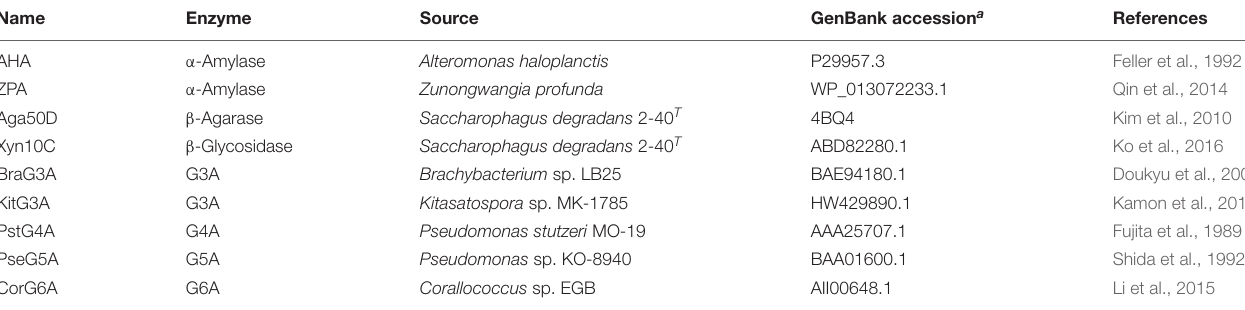
TABLE 1 | Information of the enzymes used for the comparison with SdG5A in this study.